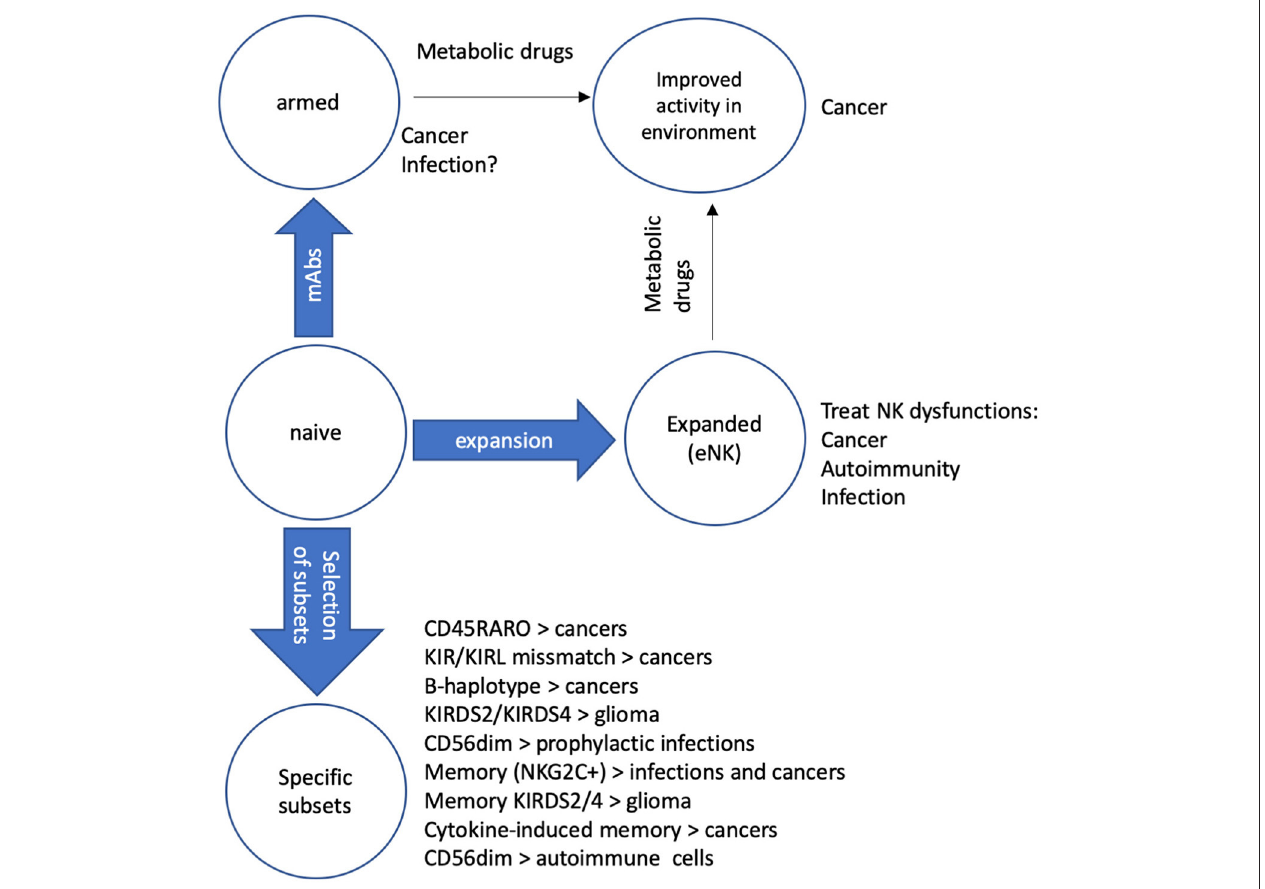
FIGURE 1 | Protocols to recover/improve NK function. We describe several mechanisms to improve NK activity in patients. Naïve NK cells can be “armed” with mAbs that recognize tumor antigens (Ags) to improve their cytolytic activity against cancer cells ( 6). If specific mAbs against Ags of different pathogens are available, they can be used to arm NK cells to fight infections, mainly in immune compromised patients (54, 55). NK cells can be expanded (eNK) to recover NK cell functions in several diseases such as cancer, autoimmune diseases and infections ( 32). Treatment of patients with metabolic drugs that modify the microenvironment of the target can increase the function of both “armed” NK and eNK ( 25, 53). We also believe that it is possible transfer specific NK cell subsets to treat different diseases such as cancers (11–13), including glioblastoma (56) that has a poor prognosis. Some NK subsets, e.x. memory NK cells could also fight infections (57) when engrafted in patients. Finally, in autoimmune diseases could be clinically relevant to replace immature CD56 bright NK, which are mostly proinflammatory with mature CD56 dim NK, which eliminate activated immune cells. These two NK subsets differentially express various chemokine receptors, which attract them to distinct organs ( 58, 59). Hence, locally playing with different chemokines should naturally facilitating the recruitment of a specific